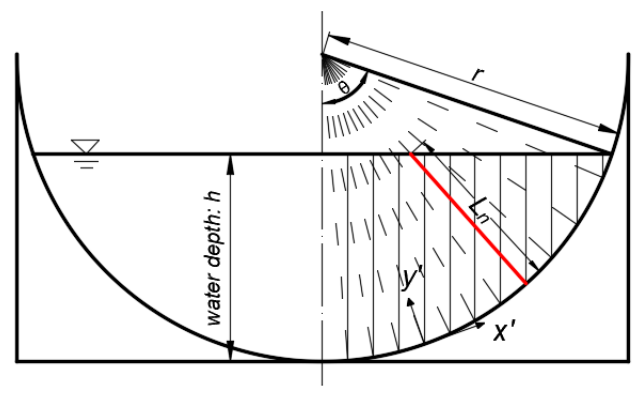
Figure 9. Semi-circular channel cross-section and notation.